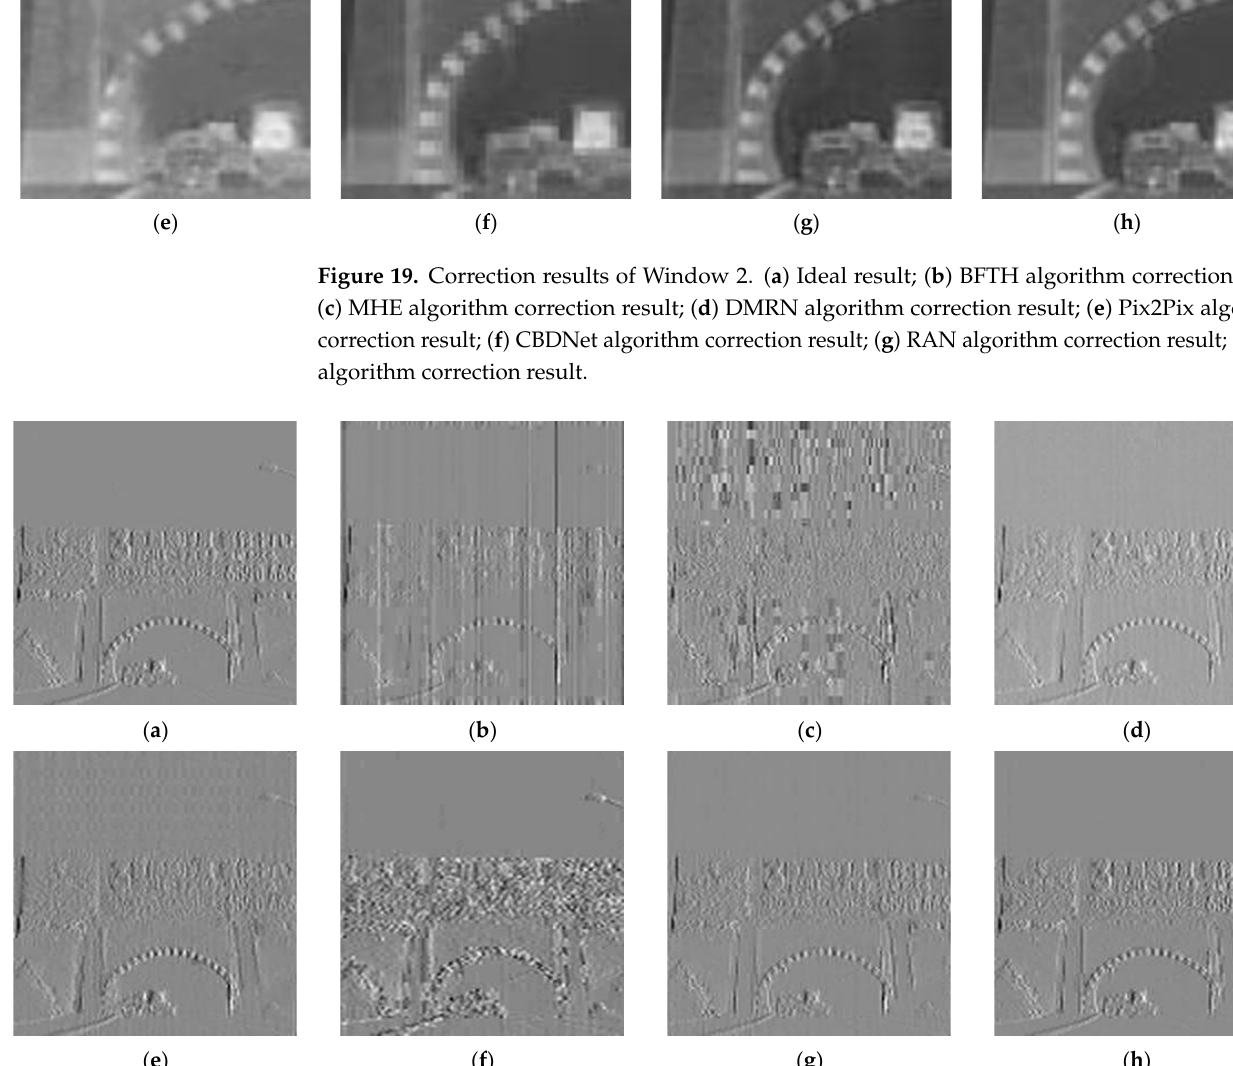
Figure 19. Correction results of Window 2. ( a ) Ideal result; ( b ) BFTH algorithm correction result; ( c )